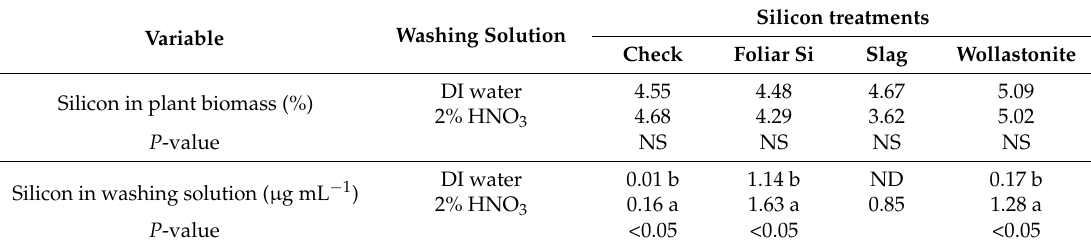
Table 4. Effect of washing the leaves with deionised (DI) water and 2% HNO 3 on silicon content of rice leaves, and silicon content of DI and 2% HNO 3 washing solution under different silicon treatments.